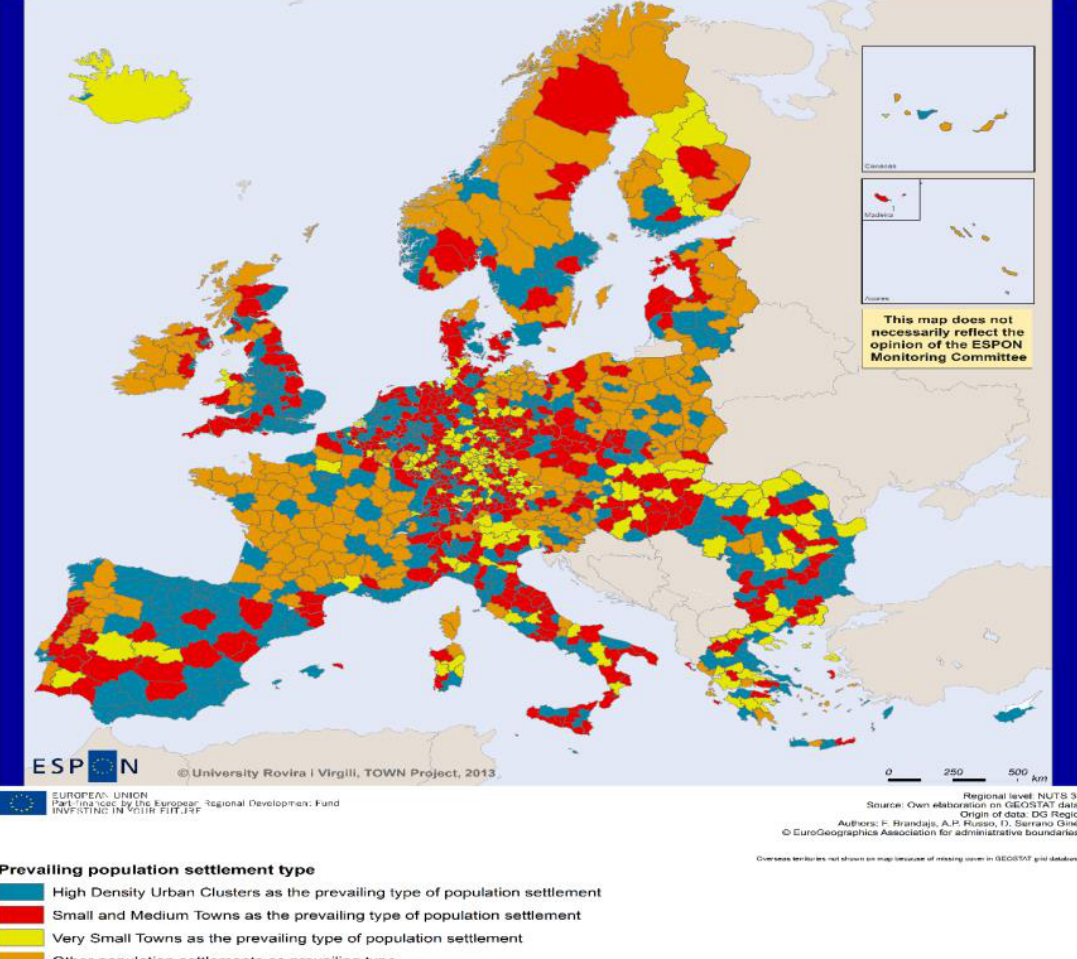
Figure 1. Map typology of demographic status. Source: www.espon.eu [17].